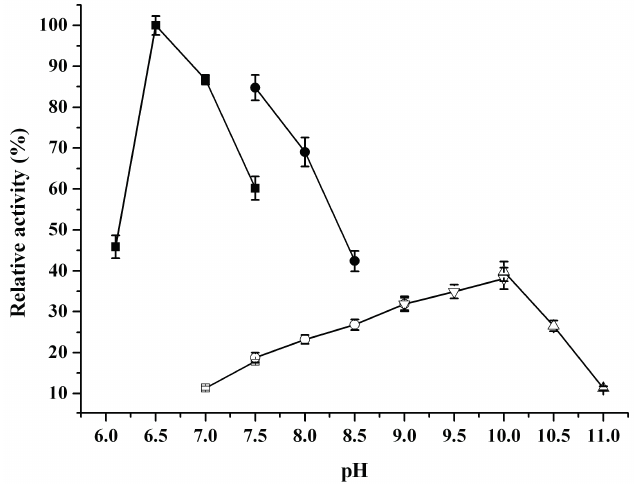
Figure 5. Effect of pH on the activities of ReBDH. The relative activity of 100% represents 11.3 U/mg for acetoin reduction at 55 °C and pH 6.5. Solid symbols, ketone reduction; empty symbols, alcohol oxidation. Buffers used: squares, piperazine- N , N '-bis(ethanesulfonic acid) (PIPES); circles, Tris-HCl; down-pointing triangles, N -cyclohexyl-2-hydroxyl-3- aminopropanesulfonic acid (CAPSO); up-pointing triangles, 3-(cyclohexylamino)-1- propanesulfonic acid